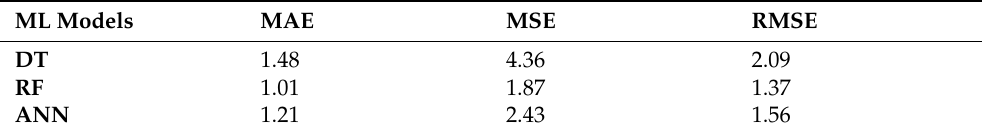
Figure 7. Graphical comparison of experimental and predicted HHV of different ML models using the test dataset. Table 2. Comparison of the statistical measurement criteria for different machine learning models.